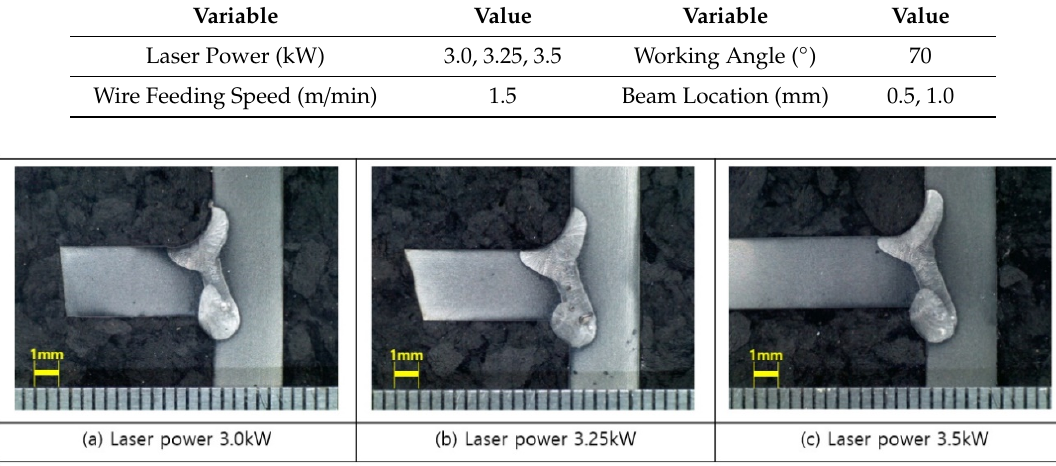
Figure 12. Applying different levels of laser power with 0.5 mm beam location.